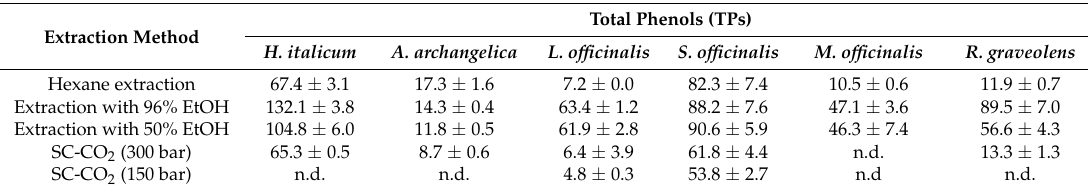
Table 4. Total phenols content in the plant extracts expressed as mg gallic acid equivalent (GAE)/g of the extract.